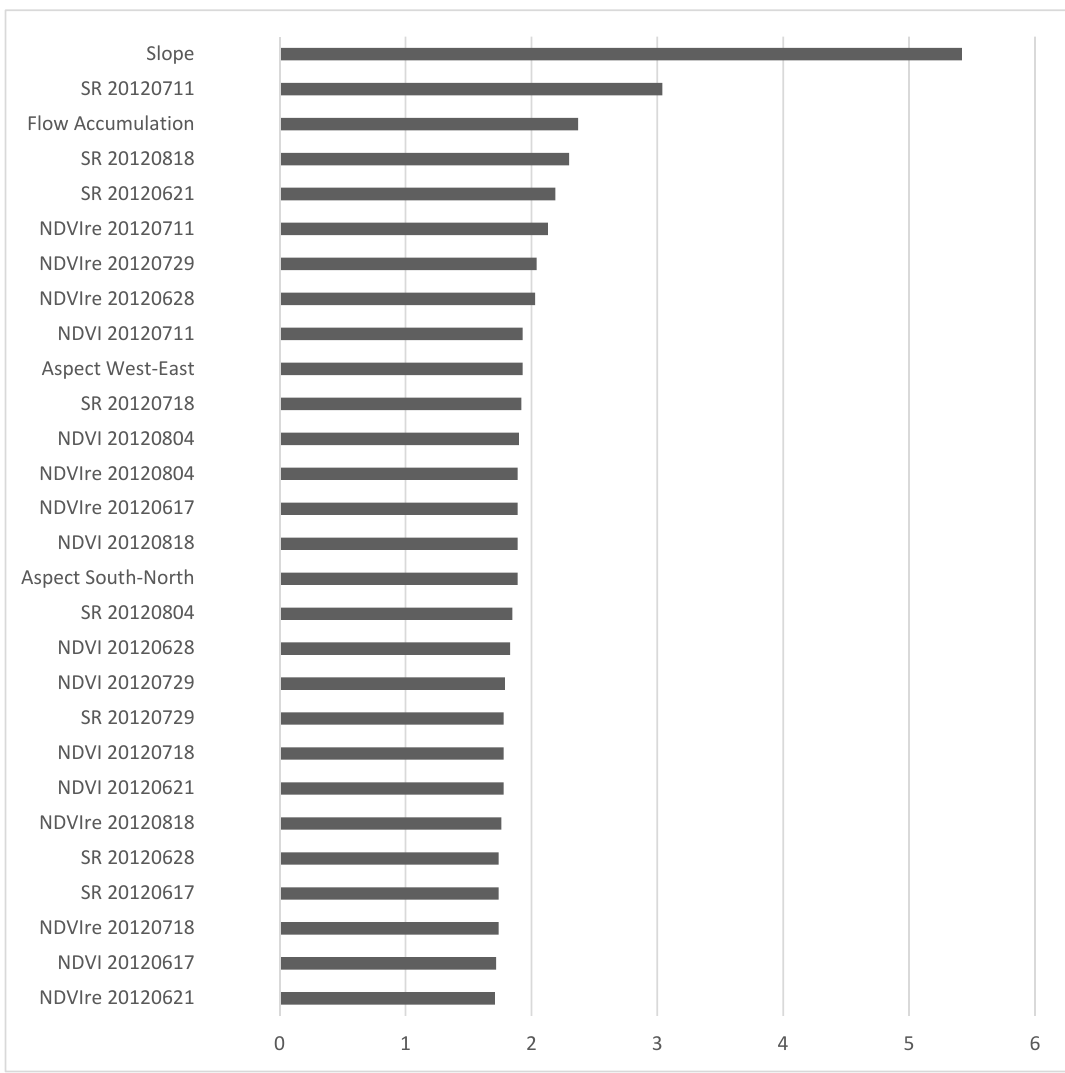
Figure A5. Importance of variables for the soybean 2012 ANN model, as measured by Garson values (larger values indicate higher importance).